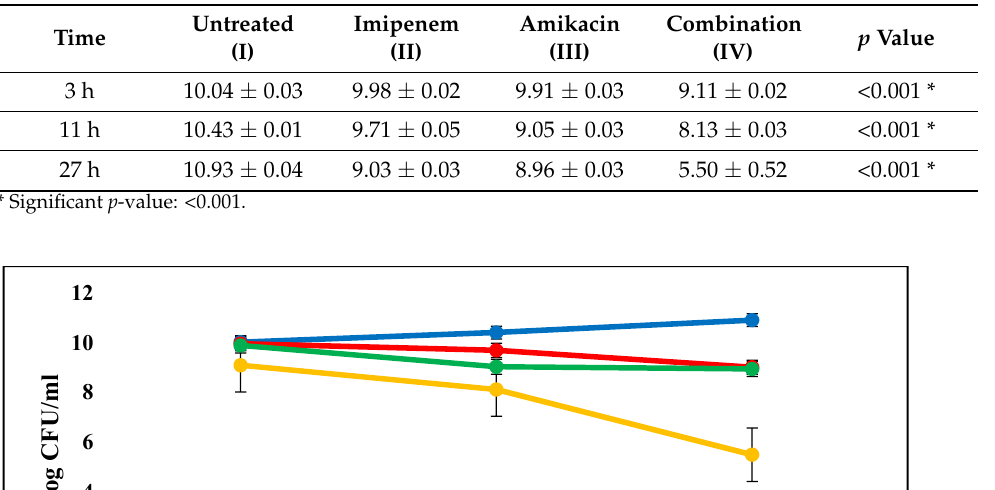
Table 6. Comparisons between different groups of Pseudomonas aeruginosa in different times.